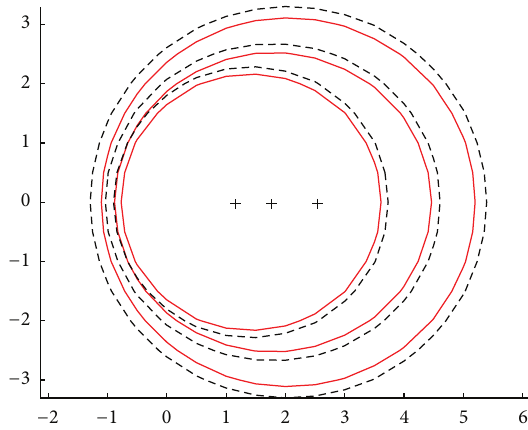
Figure 1: The red dotted line and black dashed line denote the corresponding discs Γ 1 and Γ 󸀠 1 , respectively.